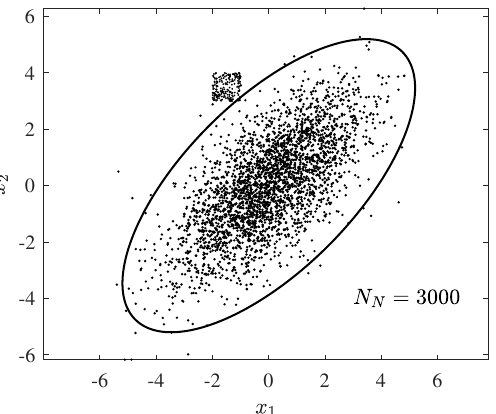
Figure 2. Example of a sample set for numerical